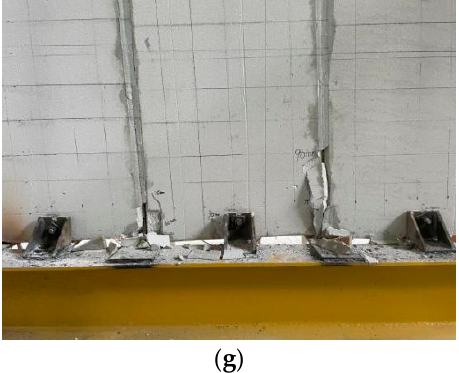
Figure 10. Experimental results of SFW3: ( a ) slip in bolt holes and bolts; ( b ) crack in the bottom of panel No. 2; ( c ) cracks extended and corner broken; ( d ) mortar crack; ( e ) obvious dislocation in panels; ( f ) extended cracks at bolt holes; ( g ) fragments of back corners.